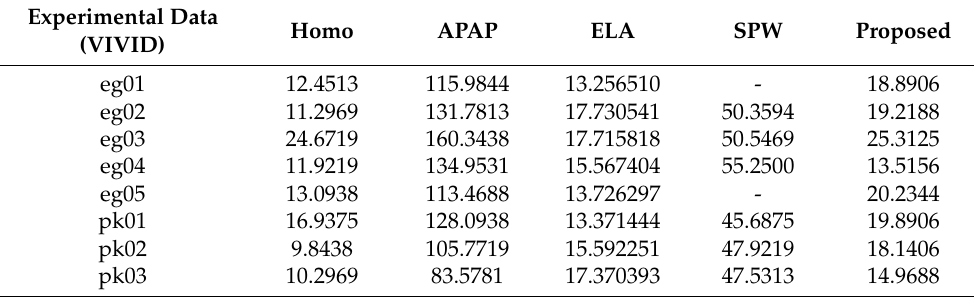
Table 2. Comparison of processing time (unit: sec).